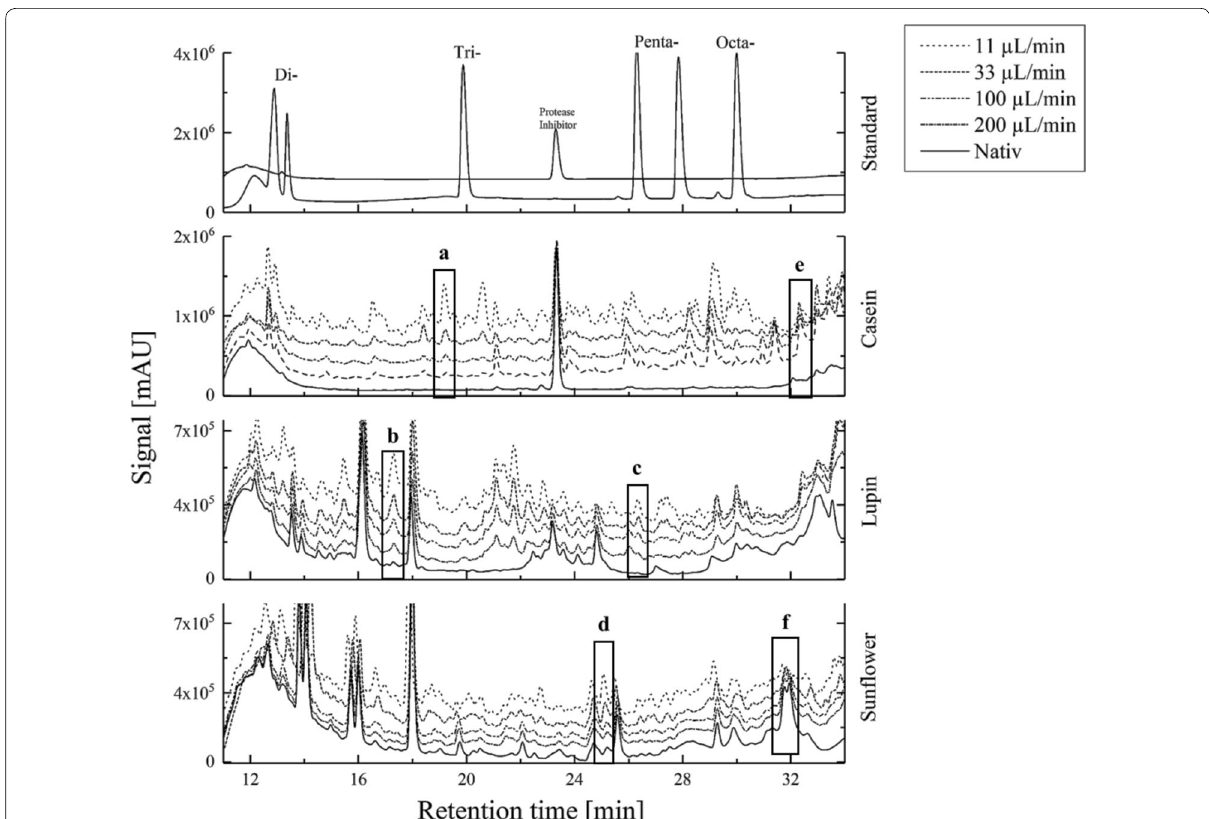
Fig. 4 Flow rate dependent protein hydrolysis of various food proteins. Increasing peak intensities with lower flow rates (a–d), peaks intensified at specific flow rates (e) and peaks decreasing with lower flow rates